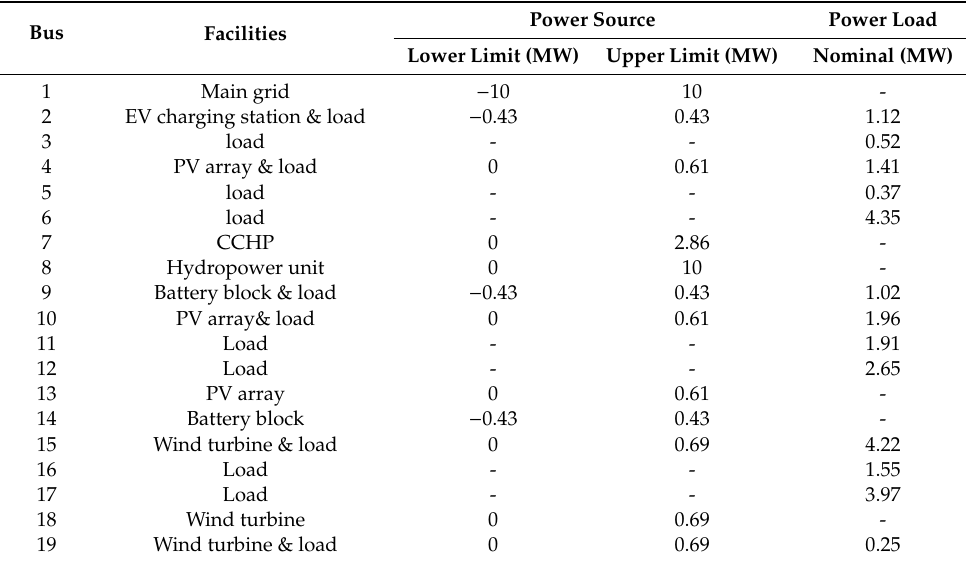
Figure 6. One-line diagram of ME-VPP in Hongfeng Eco-town.